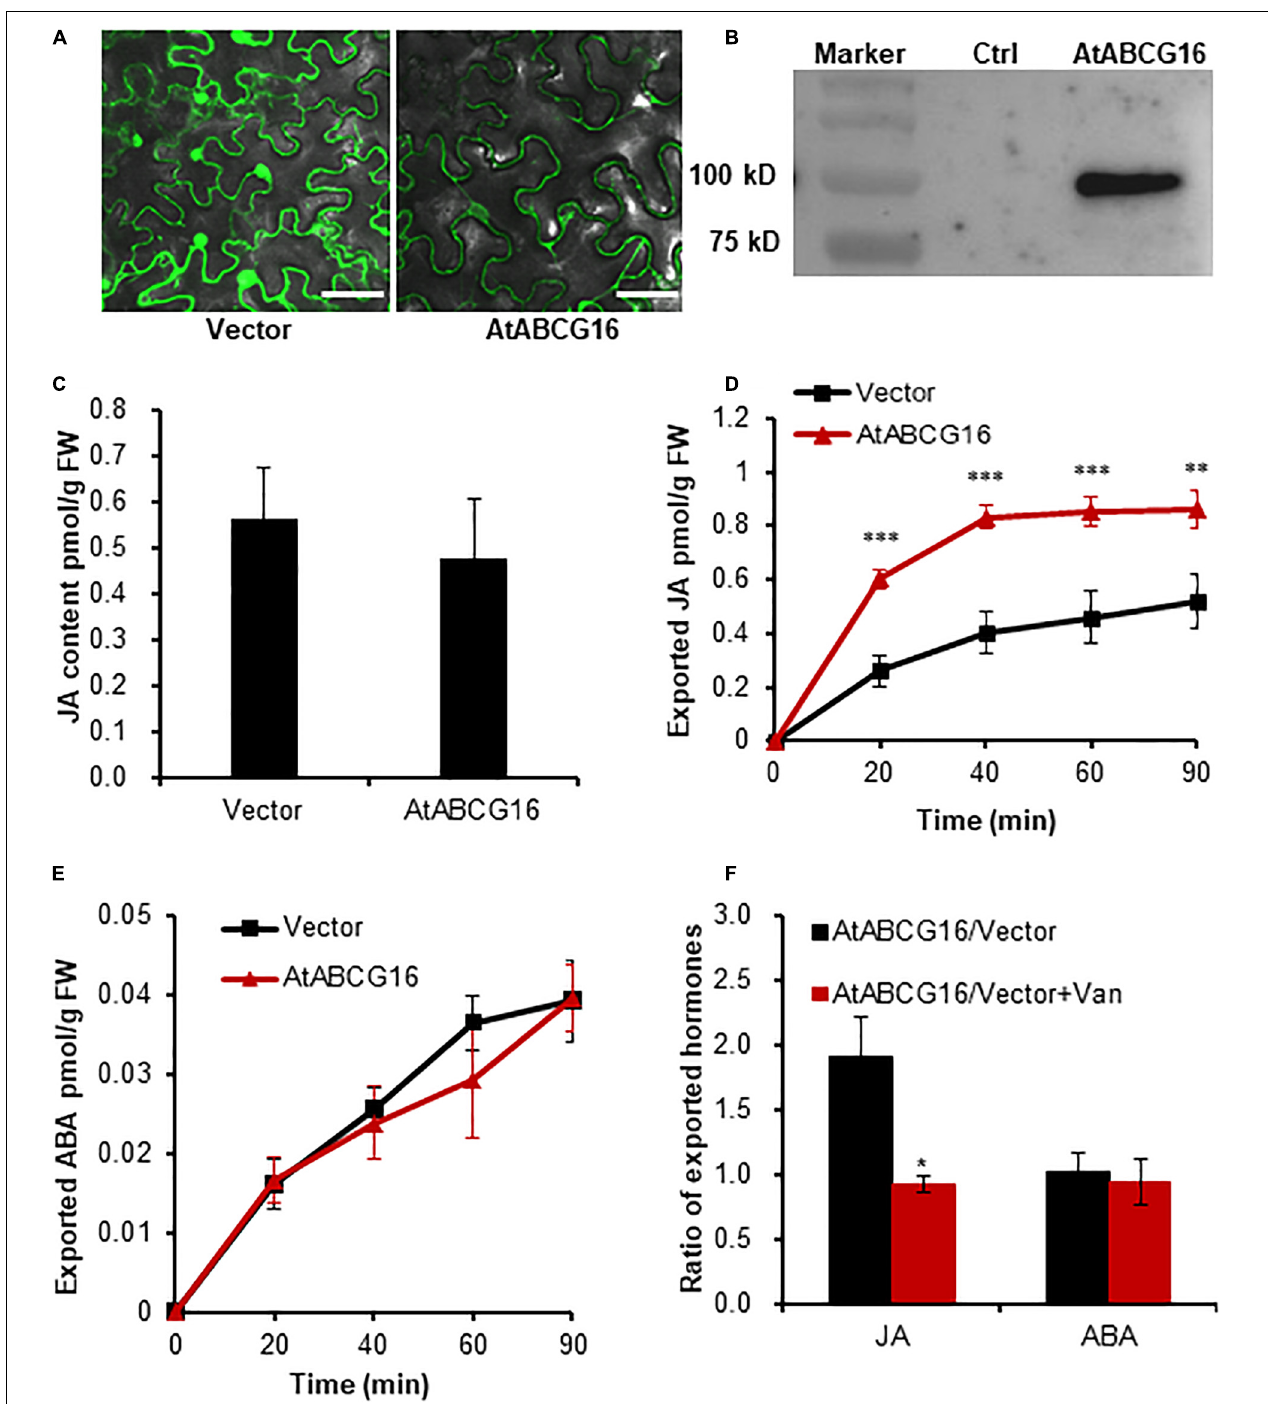
FIGURE 3 | AtABCG16-mediated efflux transport of JA in agroinfiltrated tobacco leaves. (A) Transient expression of free GFP and GFP-ABCG16 in tobacco leaves imaged by confocal microscope. Bar = 50 µ m. (B) Immunoblot analysis of GFP-AtABCG16 fusion protein expression in tobacco leaves. M, marker; G16, total protein from tobacco leaves with transient expression of 35S:GFP-AtABCG16 ; Ctrl, control, total protein from non-transgenic tobacco leaves. (C) Quantification of JA of tobacco leaves expressing an empty vector and GFP-ABCG25 before efflux experiment. (D,E) Quantification of exported JA (D) and ABA (E) from tobacco leaves transformed with GFP-AtABCG16 and free GFP at the time points of 0, 20, 40, 60, and 90 min. (F) The ratios of exported JA or ABA from tobacco leaves transformed with GFP-AtABCG16 and free GFP in the presence or absence of 1 mM of sodium vanadate at 60 min. Data are means ± SE ( n = 4). *, **, and *** indicate P -values of P < 0.05, P < 0.01, and P < 0.001, respectively, from Student’s t -test.